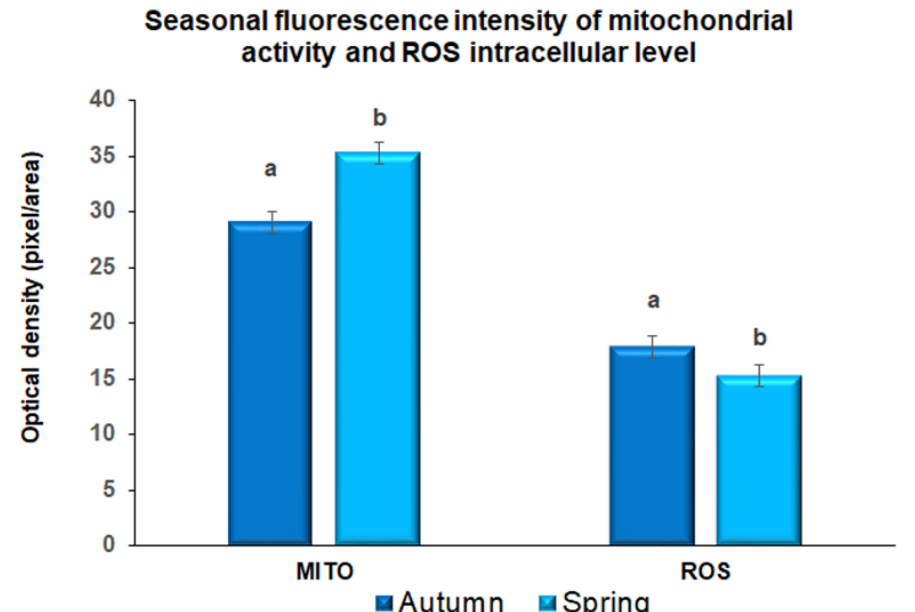
Figure 1. Quantification of fluorescence intensity after incubation with Mitotracker-Red stain (Mt- Red) and H 2 DCF-DA probe (reactive oxygen species, ROS) in metaphase II prepubertal ovine oocytes collected during autumn and spring. Values are expressed as arbitrary units (Mean ± mean standard error). Different lower-case letters indicate statistical difference into mitochondrial fluorescence